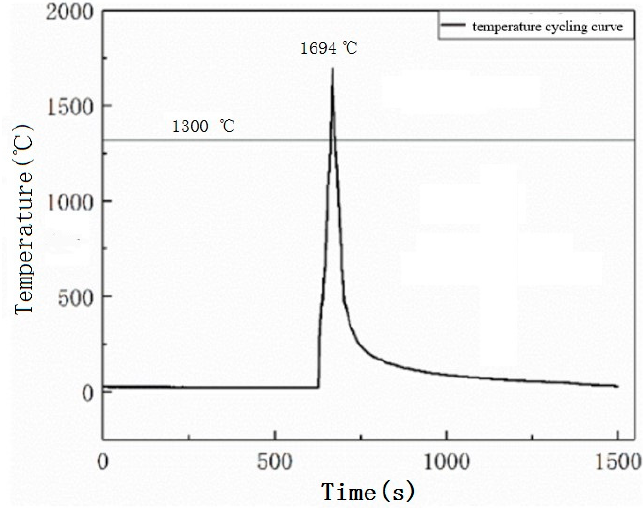
Figure 3. Thermal cycling curve at the midpoint of the center line of single-pass single-layer surfac- ing.